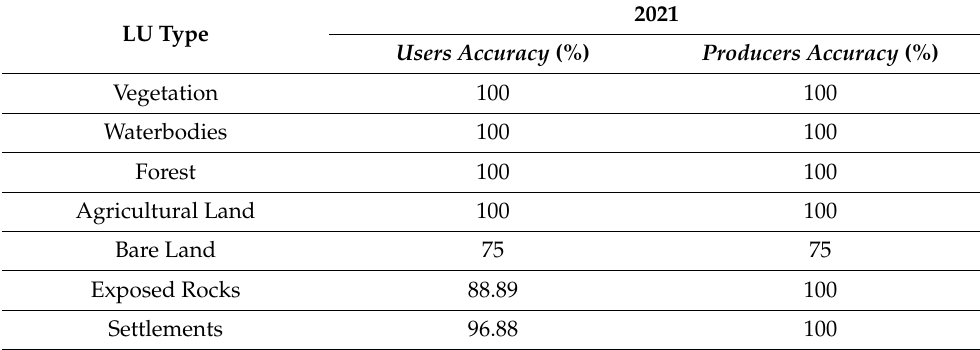
Table A9. User accuracy and overall accuracy for the LU/LC types in